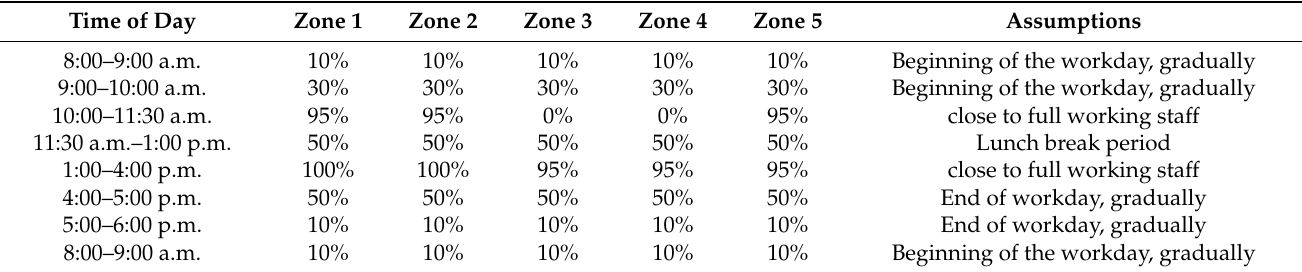
Table 3. Proposed occupancy schedule.